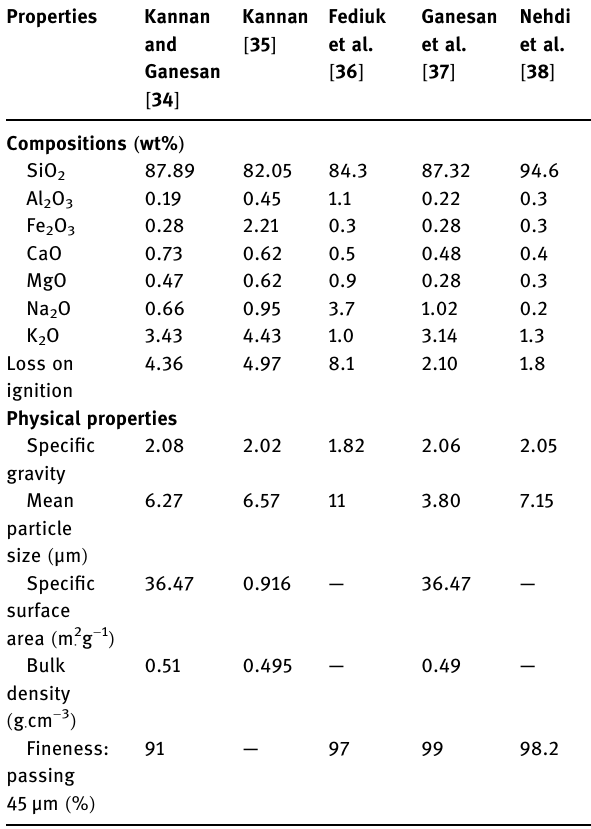
Table 1: Physical and chemical properties of RHA